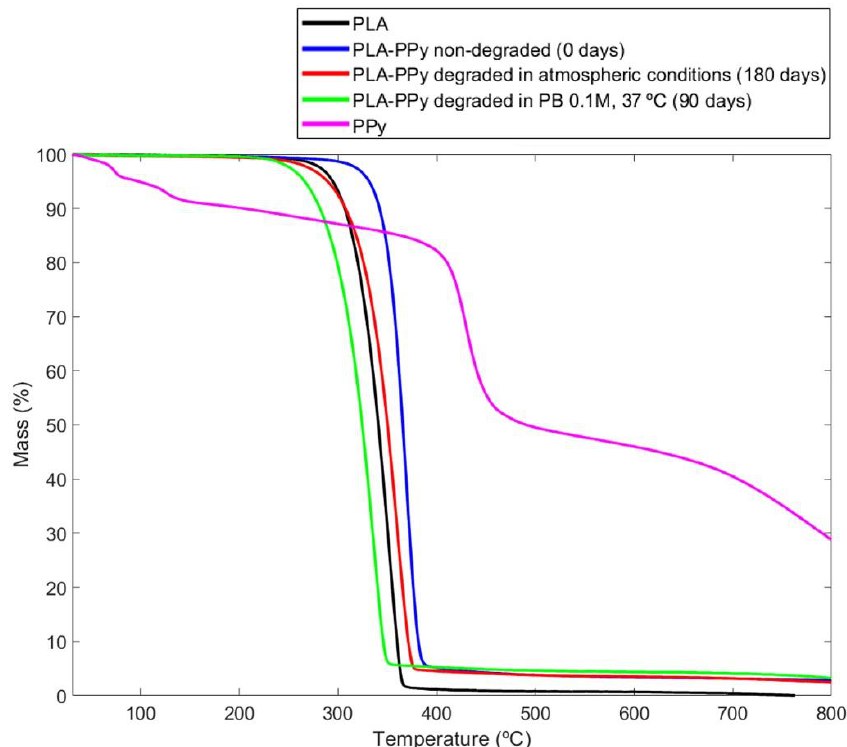
Figure 3. Thermogravimetric analysis (TGA) of PLA microfibers (PLA), non-degraded PLA-PPy microfibers, PLA-PPy microfibers degraded in atmospheric conditions for 180 days, PLA-PPy microfibers degraded in PB 0.1M at 37 °C for 90 days and pure PPy (PPy).